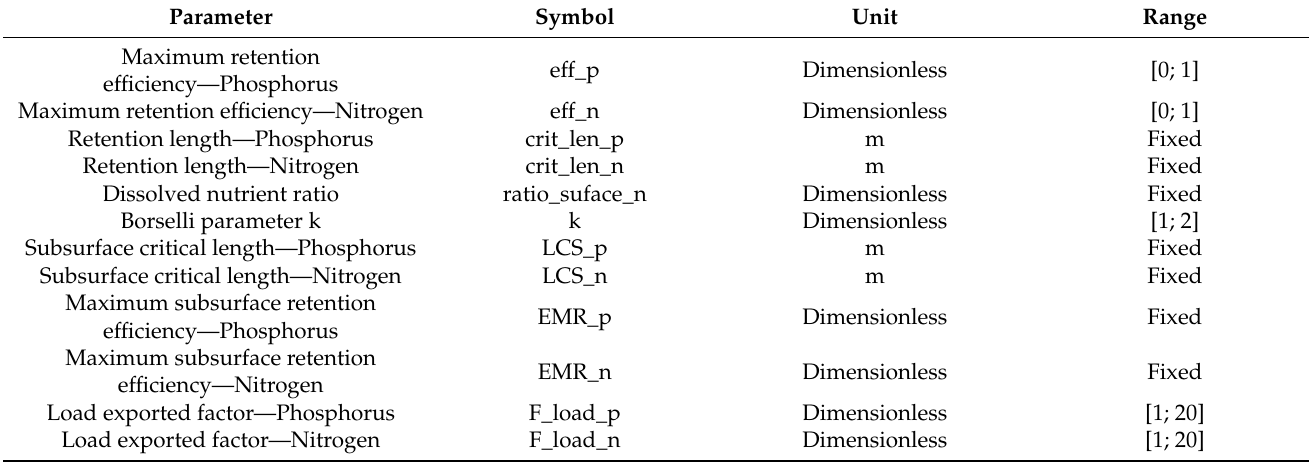
Table 10. Nutrient Delivery Ratio model